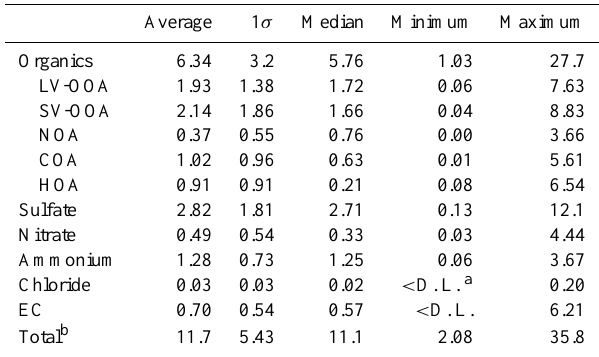
Table 1. Summary of the mass concentrations (µgm − 3 ) of NR- PM 1 species, OA components, and